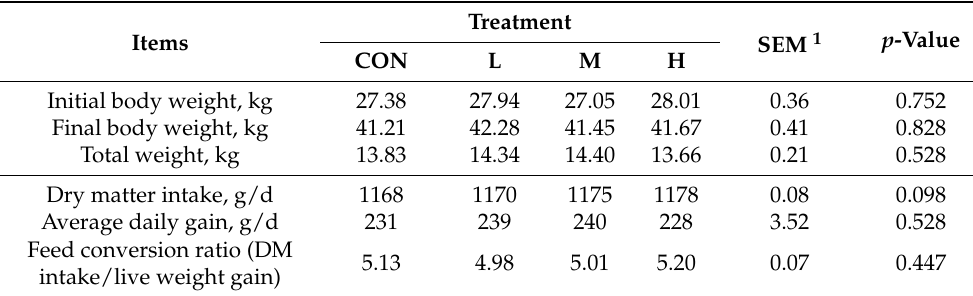
Table 3. Effects of replacing 0 (CON group), 20 (L group), 40 (M group) and 60% (H group) of maize silage with mulberry silage on lambs’ feed intake and growth.